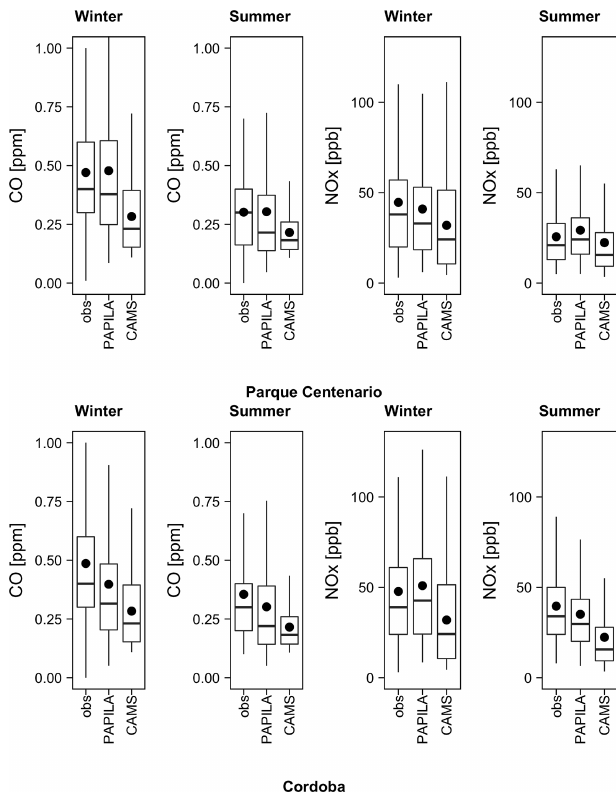
Figure 5. Boxplots of hourly CO and NO x at both sites for summer and winter simulations. The dots represent the average value, the thick lines represent the medians for each period, the vertical hinges represent data points between the 25th and 75th percentiles, and the whiskers represent data points between the 5th and 95th percentiles. CO concentrations are in parts per million and NO x in parts per